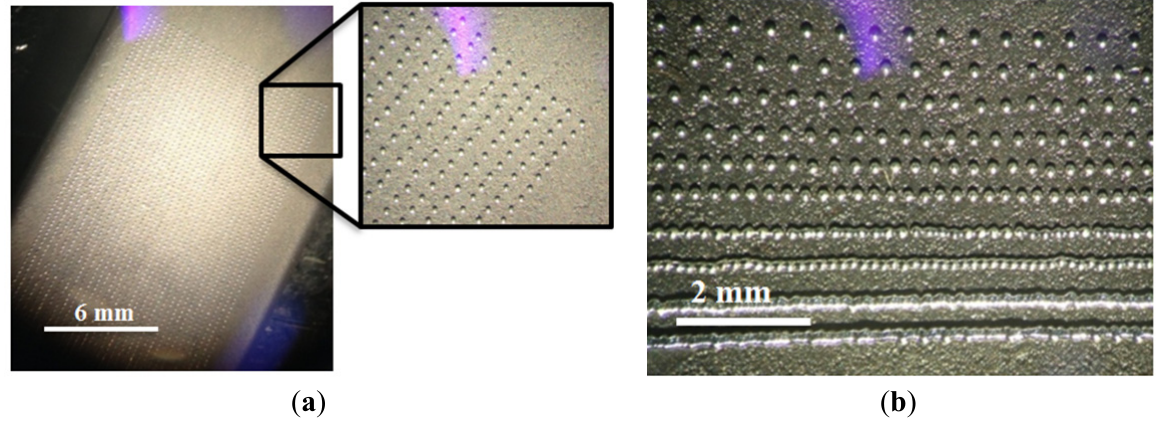
Figure 13. ( a ) Picture of a Drop-on-Demand (DoD)-mode printed pattern (solder: Sn95Ag4Cu, droplet diameter D = 88 μ m) using a constant pitch of 400 μ m. ( b ) Picture of a DoD-mode printed pattern (solder: Sn95Ag4Cu, droplet